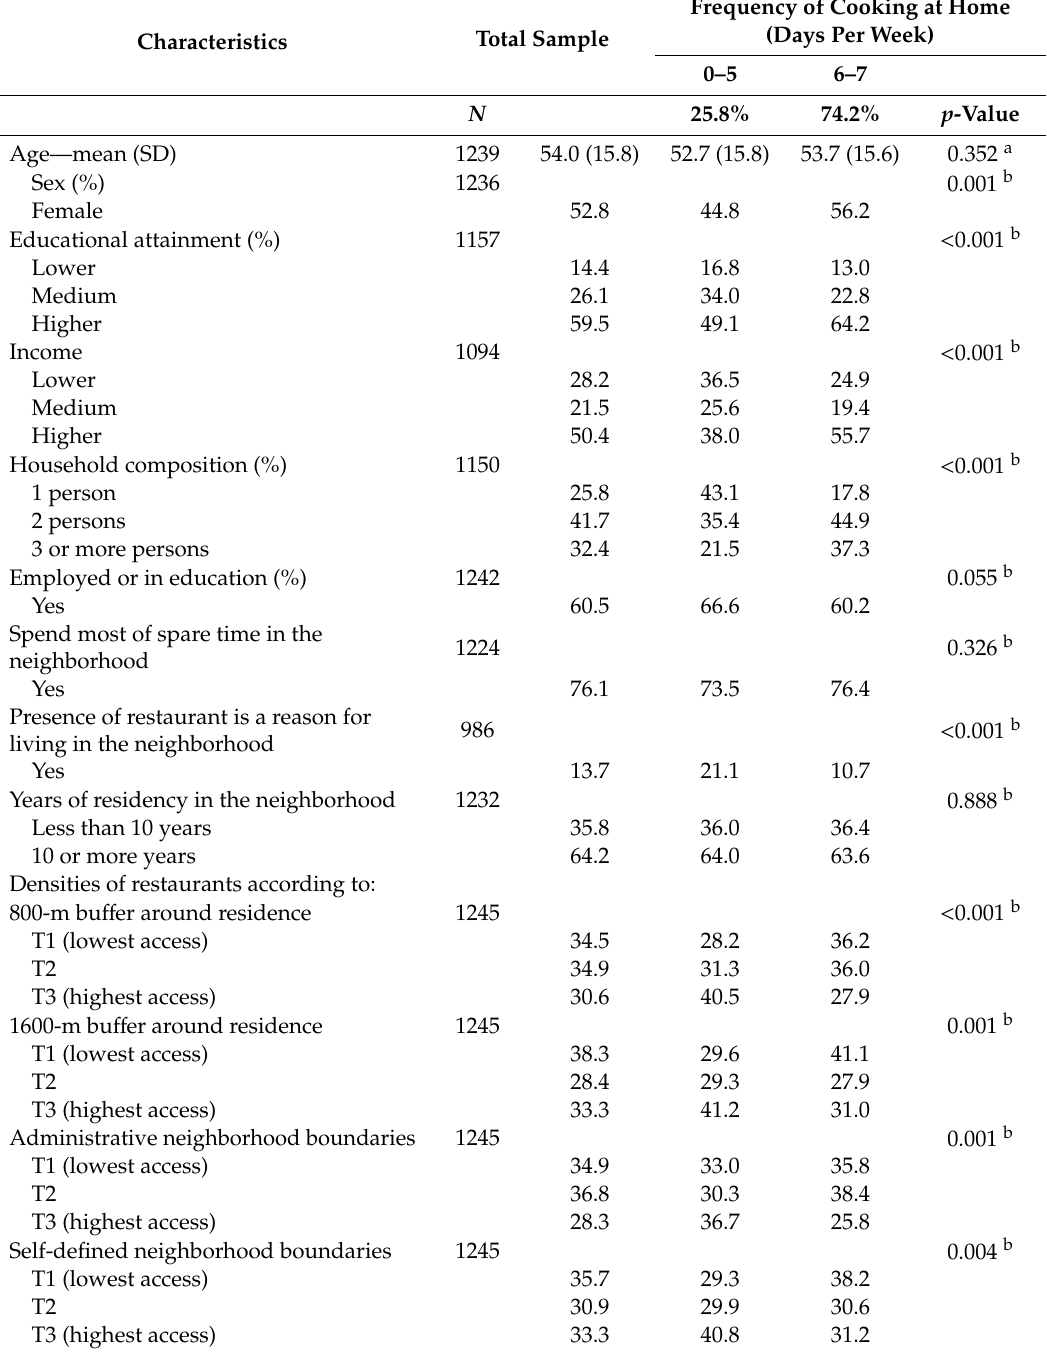
Table 2. Descriptive characteristics of the Dutch SPOTLIGHT participants by total sample and according to the frequency of cooking at